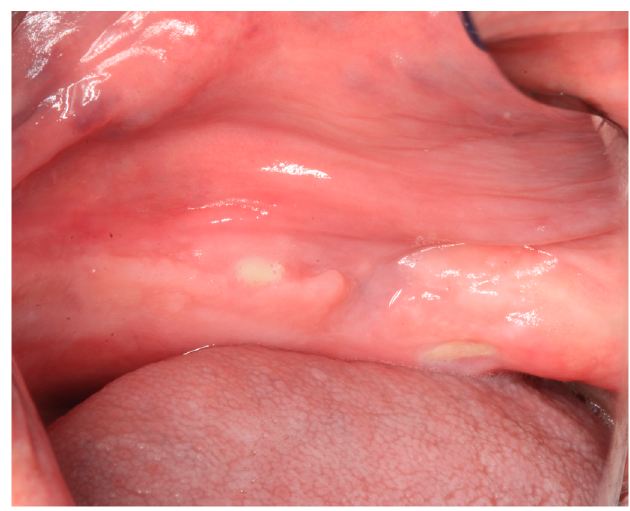
Figure 3. Case 1: Oral aspect of the bone exposition with the oral fistula.